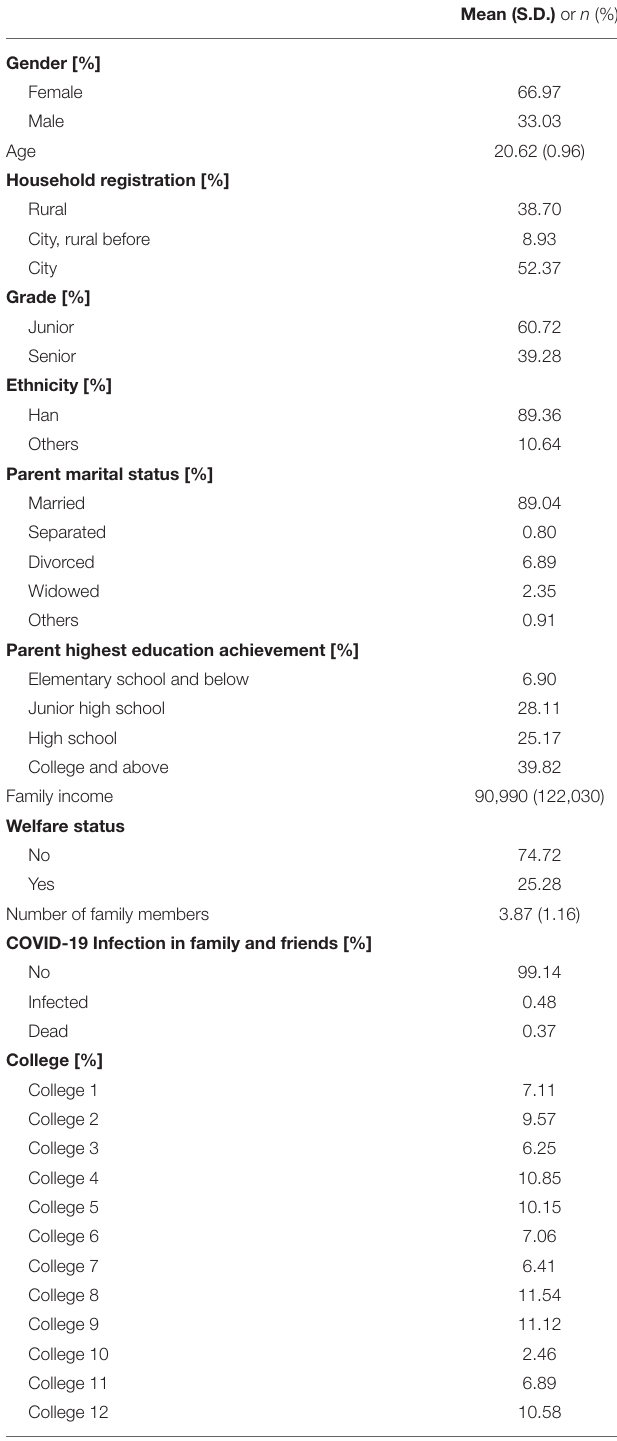
TABLE 2 | Descriptive statistics of socioeconomic